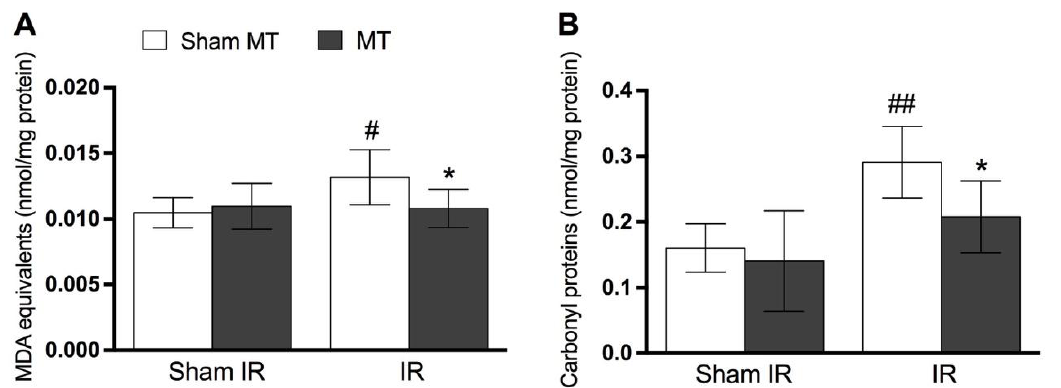
Figure 3. Evidence of the effects of MT on oxidative stress markers at the 2nd day after the IR procedure. Panels show the preventive effect of MT on the increase of MDA (panel A ) and carbonyl proteins (panel B ). Each point represents the mean of 8 animals and vertical lines show the SD. Statistical analyses were performed by one-way ANOVA followed by Newman–Keuls Multiple Comparison Test. The symbols denote a significant difference of * p < 0.05 when compared to IR + Sham MT group, # p < 0.05 or ## p < 0.001 when compared to Sham + Sham MT group. MT: Manual therapy, IR: Ischemia and reperfusion, MDA: Malondialdehyde.